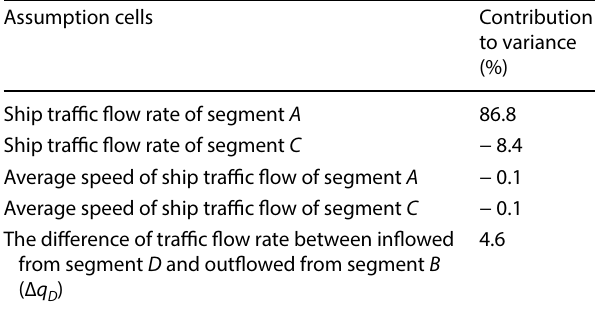
Fig. 13 Simulation results of the number of ships affected ( T Table 12 Sensitivity analysis of the total number of ships affected (